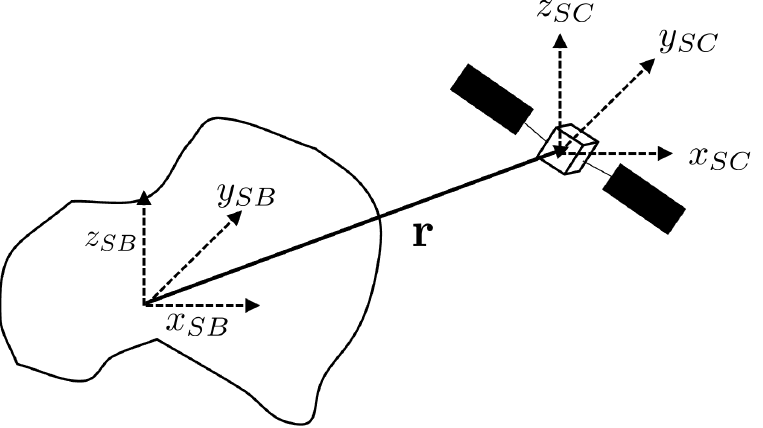
Figure 2. Spacecraft rigid body with respect to